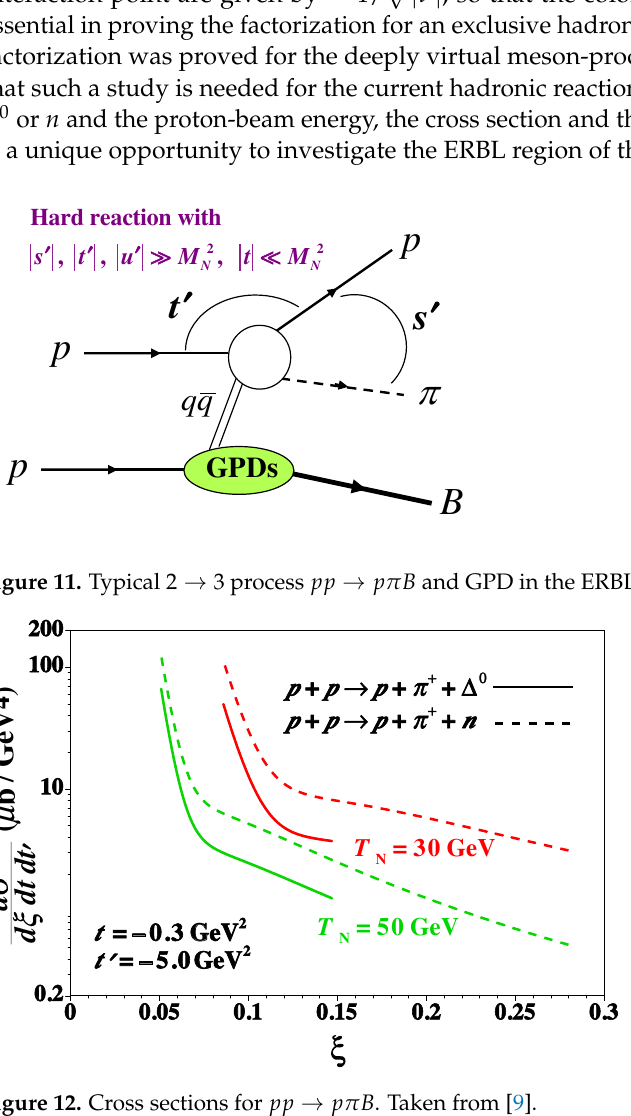
Figure 12. Cross sections for pp → p π B . Taken from